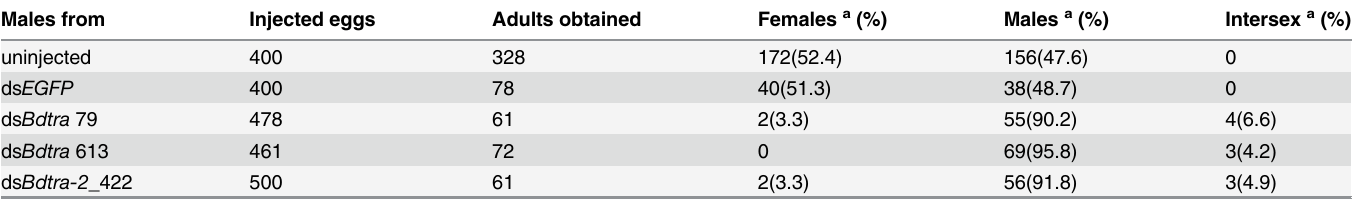
Table 1. Statistics on knock-down phenotypes of Bdtra and Bdtra-2 by dsRNA injection. Males